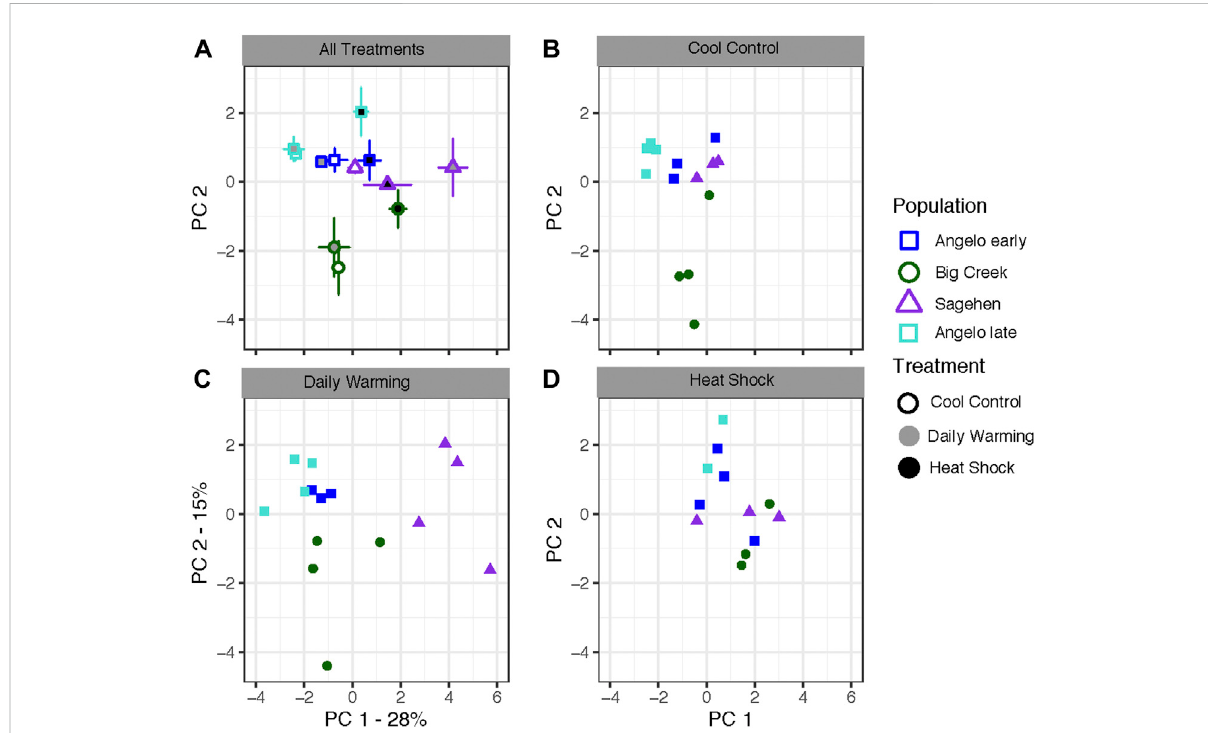
FIGURE 2 Gene expression analysis of Dicosmoecus gilvipes caddis fl ies exposed to three different temperature treatments. PC 1 represents 28% of the variation, whilePC 2represents15%ofthevariation. (A) Mean PCscoresfor allpopulation andtreatment combinations.Pointsrepresent meanswith standarderrorbarsalongbothaxes.Pointoutlinesrepresentpopulationoforigin, fi llcolorrepresentsthetreatment (B – D) Individualsplottedbytheir scores on PC1 and PC2 in the (B) cool control treatment, (C) daily stream warming treatment, and (D) heat shock treatment. This analysis removed one outlier point from Sagehen